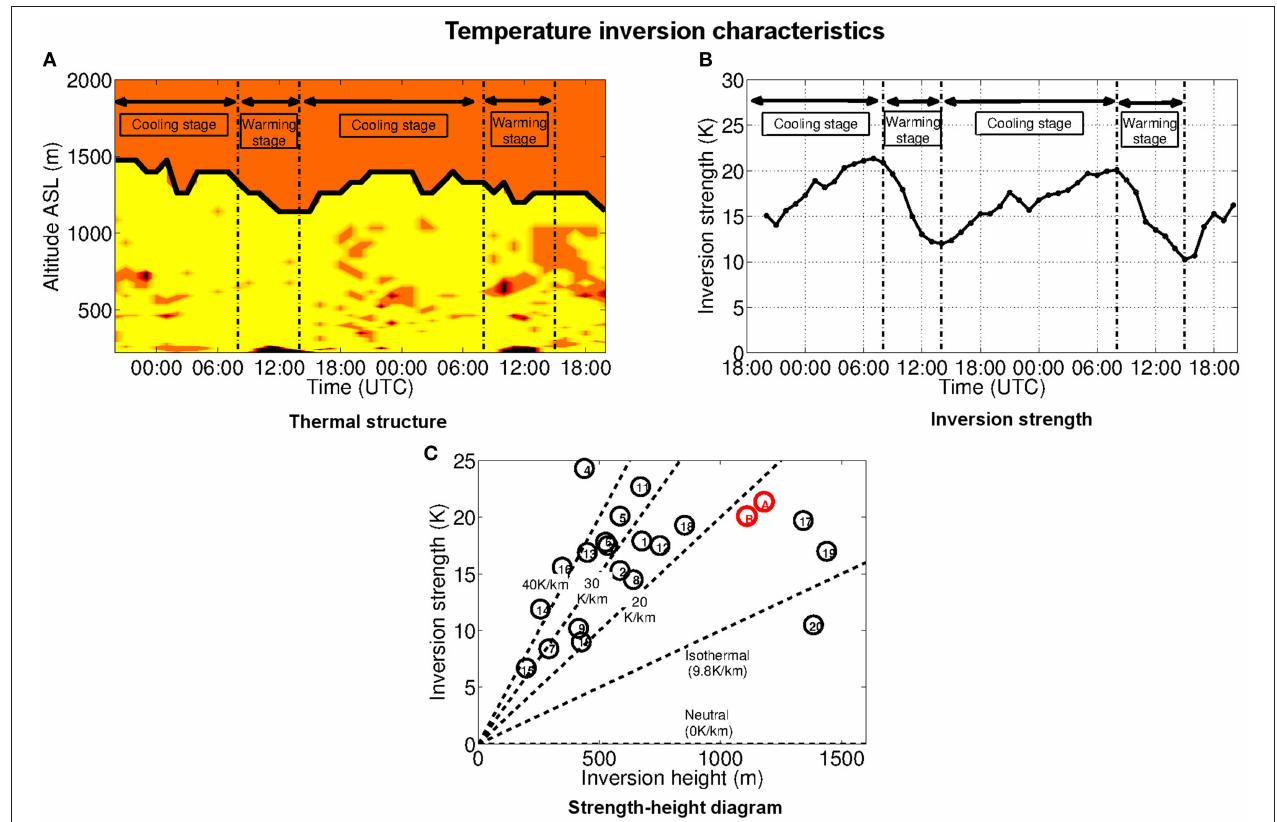
FIGURE 10 | (A) Vertical profile of ∂θ ∂ z above point Gr (see Figure 7A ) from 27 December, 18:00 UTC to 29 December, 20:00 UTC. Black : ∂θ ∂ z < 0 . Orange : 0 < ∂θ ∂ z < | γ adiab | . Yellow : ∂θ ∂ z > | γ adiab | . (B) Inversion strength 1θ over the same time period. (C) Inversion strength vs. inversion height for 20 case studies of wintertime persistent inversions in the Rocky mountains (extracted and adapted from Whiteman et al., 1999b). Red symbols: parameters of the thermal inversion I 6 on 28 December 2006 (A) and 29 December